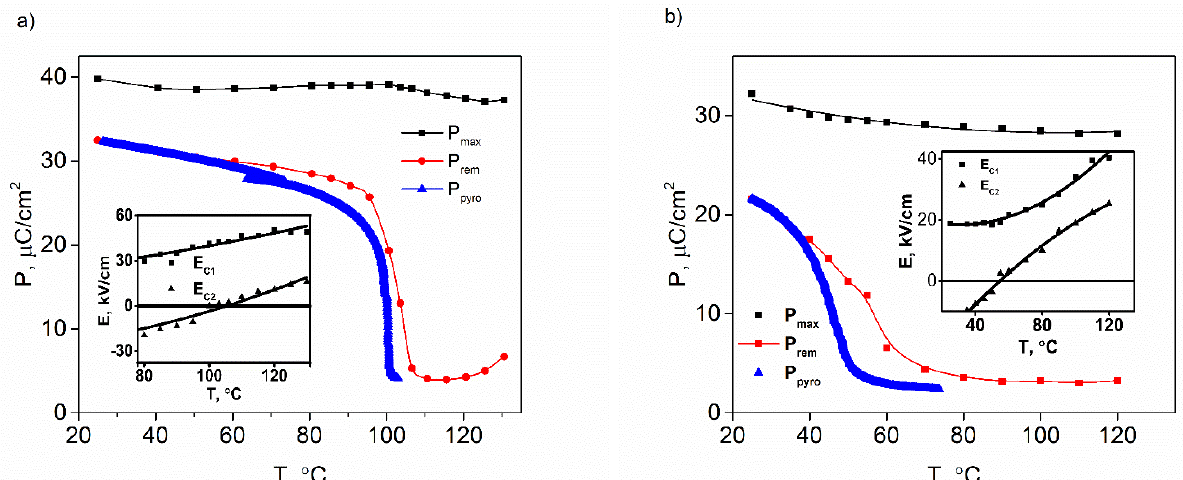
Figure 3. Temperature dependences of maximal ( P max ) and remnant ( P rem ) polarization for (1 − x)(0.8NBT-0.2BT) − xCT compositions with x = 0.050 ( a ) and 0.075 ( b ), determined from polarization hysteresis loops, as well as from static pyroelectric effect measurements. Inset in ( a ): Temperature dependence of the critical electric fields for the composition with x = 0.050. Inset in ( b ): Temperature dependence of the critical electric fields for the composition with x = 0.075.